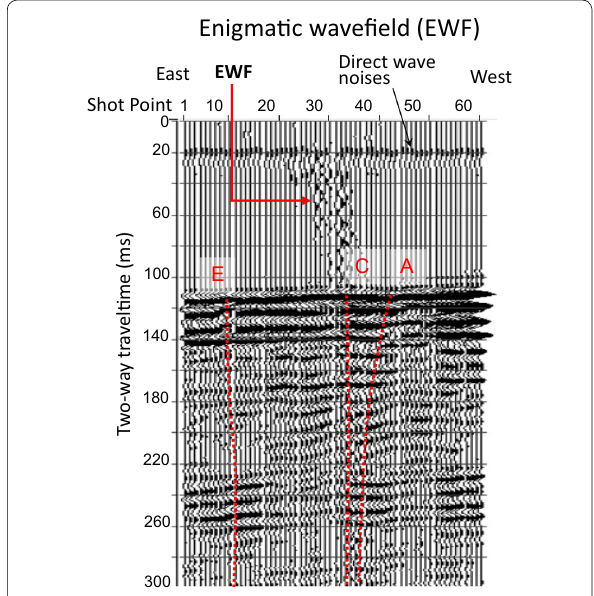
Fig. 5 An enlarged section of the MCS profile of line 10. The EWF can be seen within the water column above the seafloor near Fault C. Remaining noise from the direct waves from the source to the receiver can be seen around 20 ms in two‑way travel